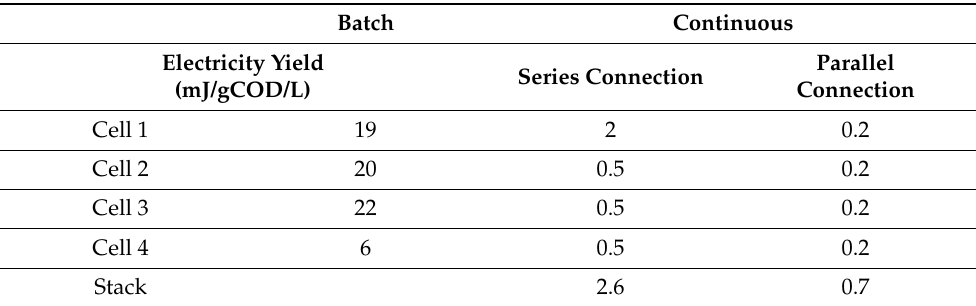
Table 1. The electricity yield (mJ/gCOD/L) of the individual cells and the stacks and the units within the stack during batch and continuous